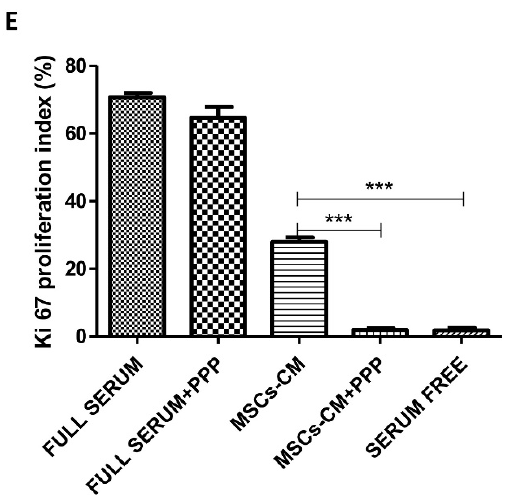
Figure 3. Regulatory role of IGF1 in the determination of MSC-induced PPC proliferation. ( A ) PPCs were cultured with MSCs-CM for 48 h and processed the analysis of IGF1R gene expression. ( B ) A BrdU assay was performed to evaluate the proliferation induced by additional IGF1 at the dosage of 0.1, 5, and 20 ng / ml. ( C ) MSCs-CM induced PPC proliferation was detected by BrdU assay with the administration of picropodophyllin ( PPP) in a dose dependent manner (0.01, 0.1, and 0.5 µ M). PPCs were cultured in full serum, MSCs-CM, or serum-free conditions in the presence or absence of PPP (an IGF1R inhibitor) for 48 h prior to immunofluorescent analysis of Ki67 ( D ) and ( E ). DAPI and Ki67 staining were expressed in blue and red, respectively. Scale bar = 40 µ m. (n = 5 per group; * p < 0.05, ** p < 0.01, *** p < 0.001. All data are expressed as means ± SEM).